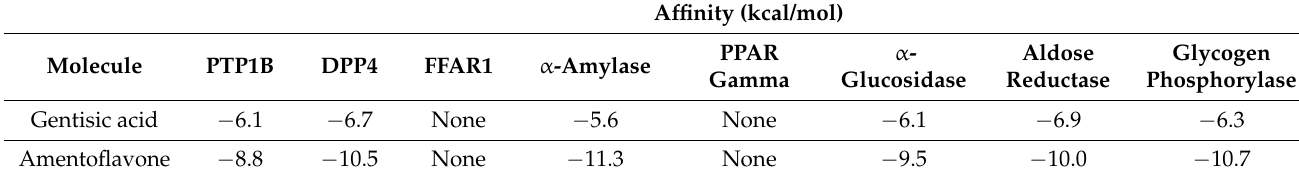
Table 1. Overview of affinities of gentisic acid to